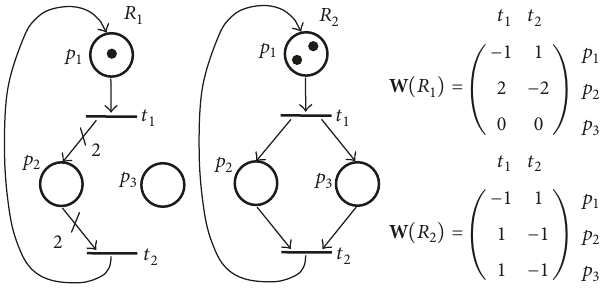
Figure 2: Petri nets obtained from a compound Petri